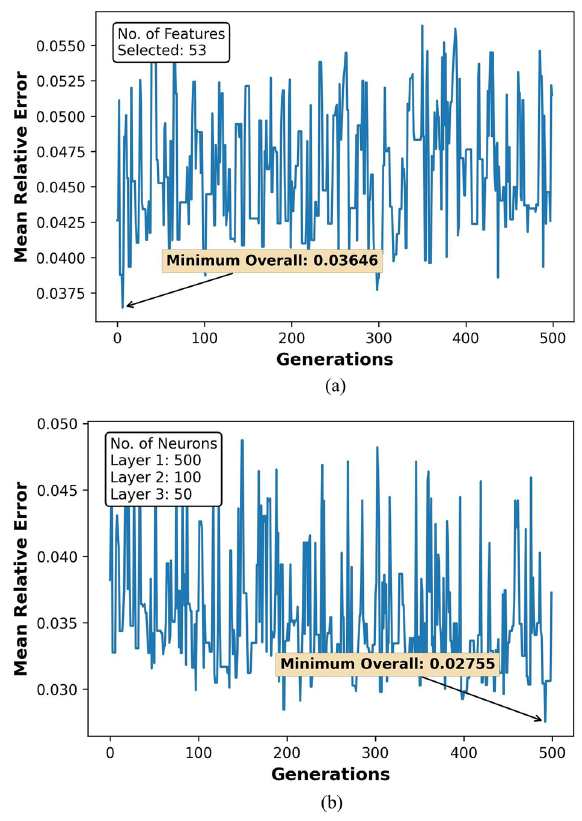
Figure 9. MRE for regressor ANN model during ( a ) feature selection and ( b ) hyperparameter tuning for HO-NF